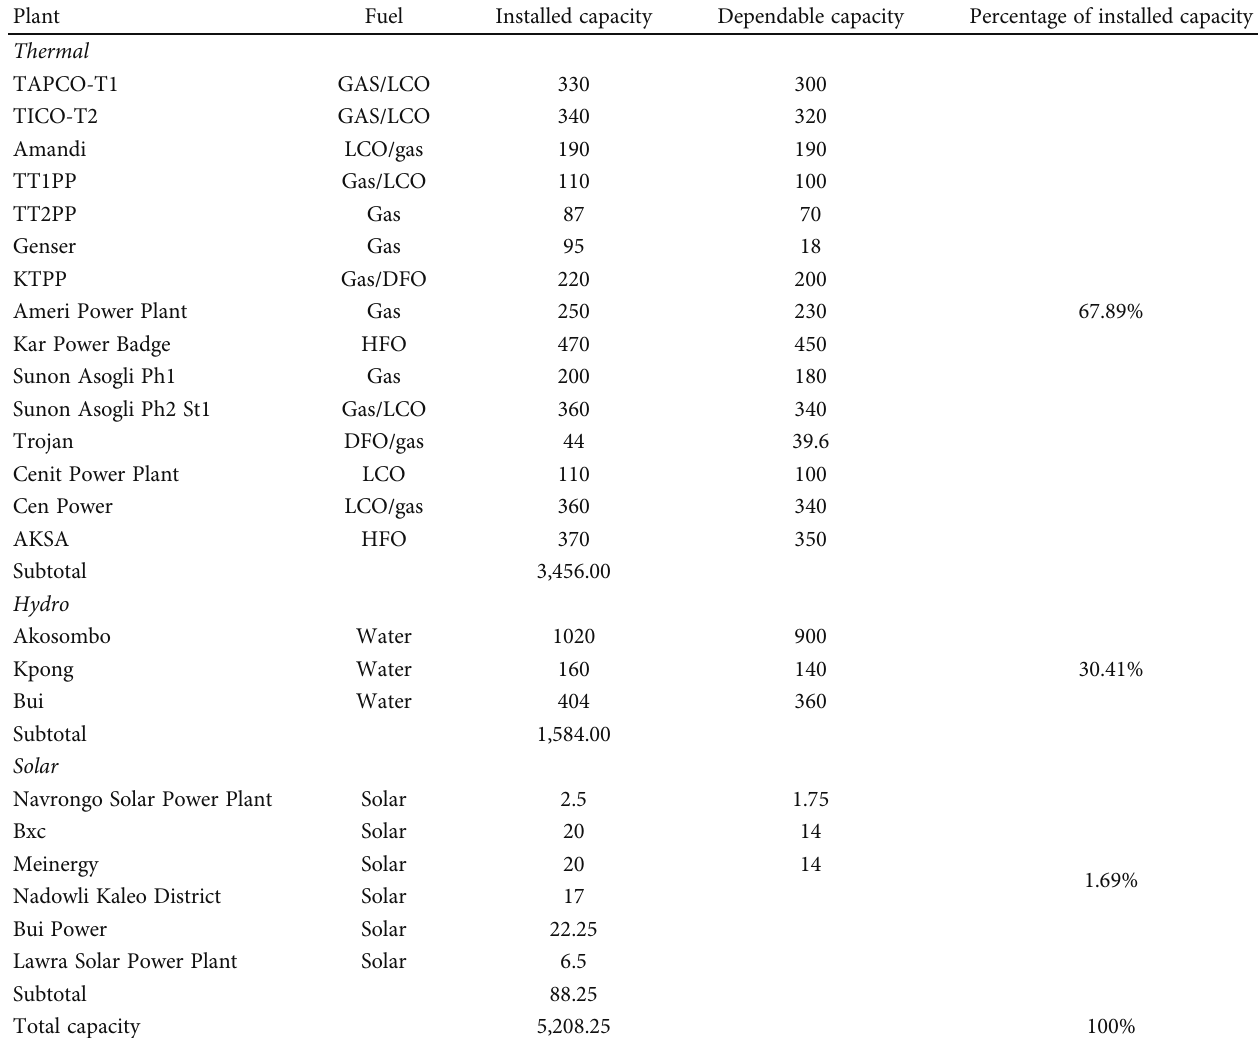
Table 1: Current installed generation capacity for VRA and IPPs in Ghana [18].